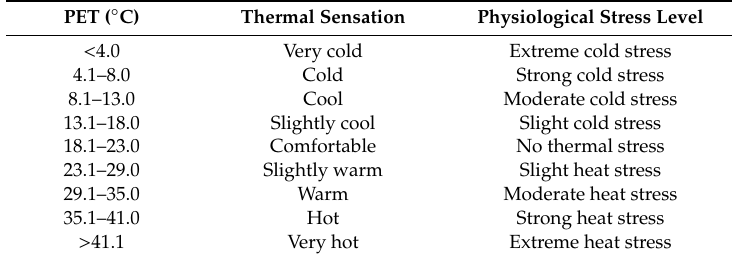
Table 2. Physiologically equivalent temperature (PET) for di ff erent grades of thermal sensation and physiological stress on human beings